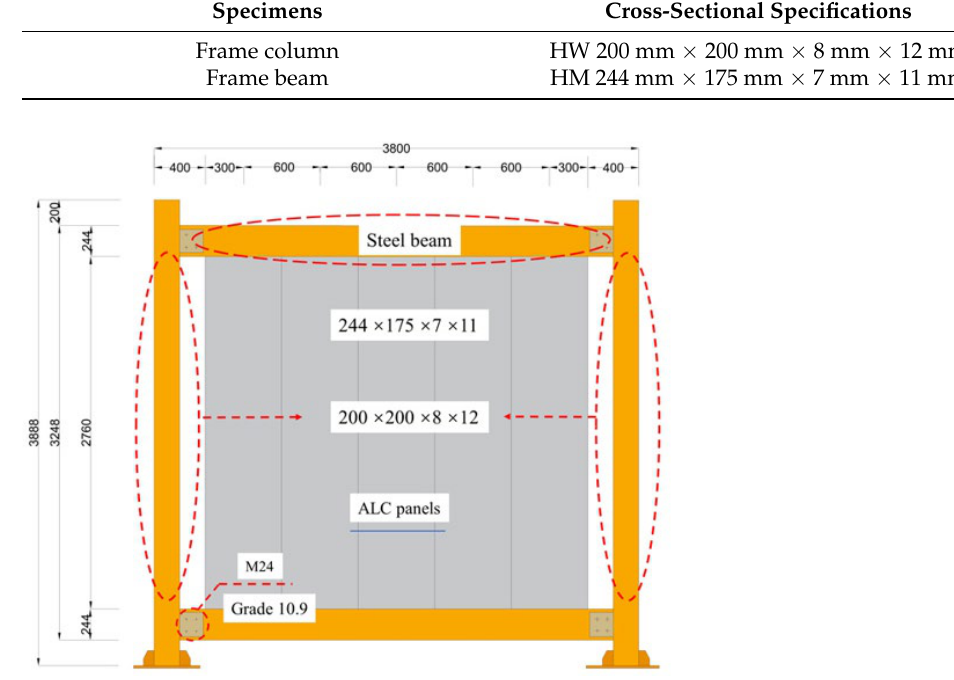
Figure 2. Dimensions of specimens (unit: mm).